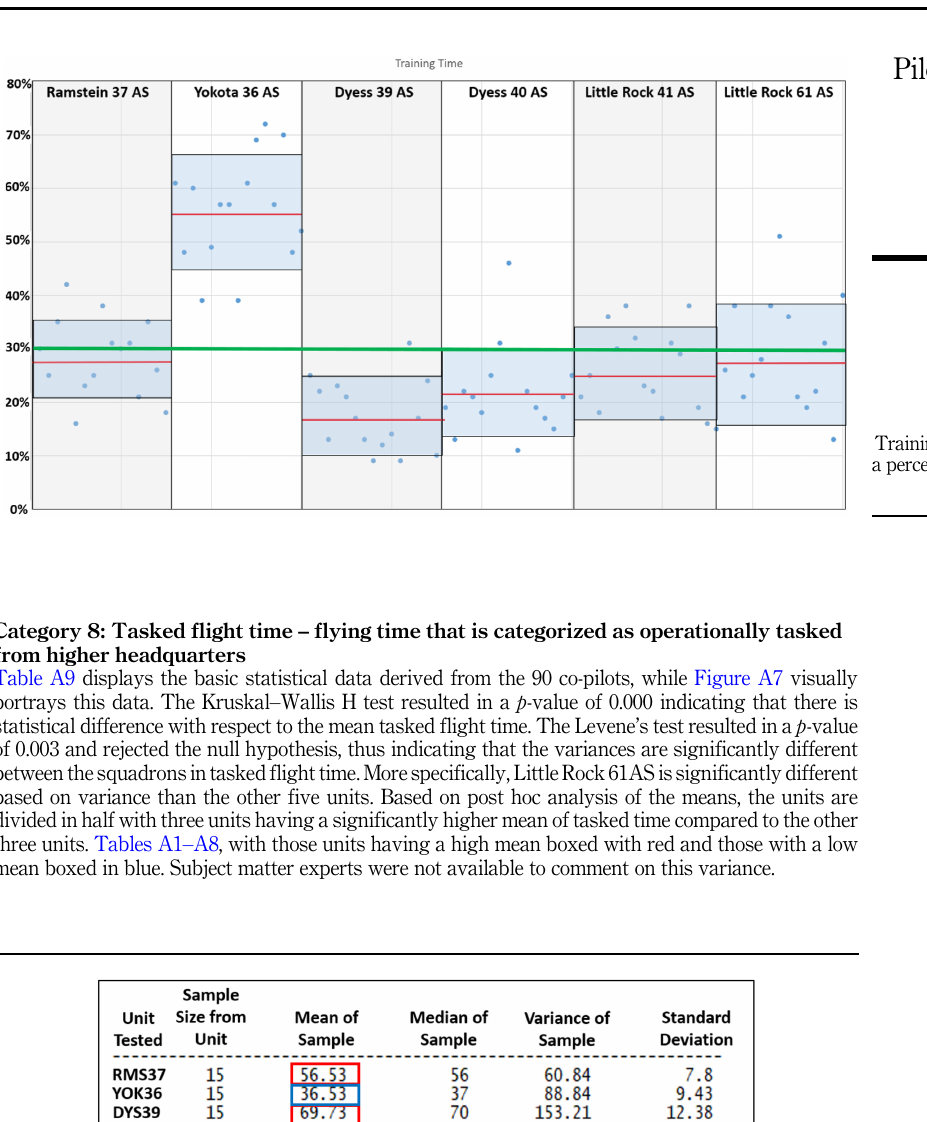
Table A5. Tasked flight